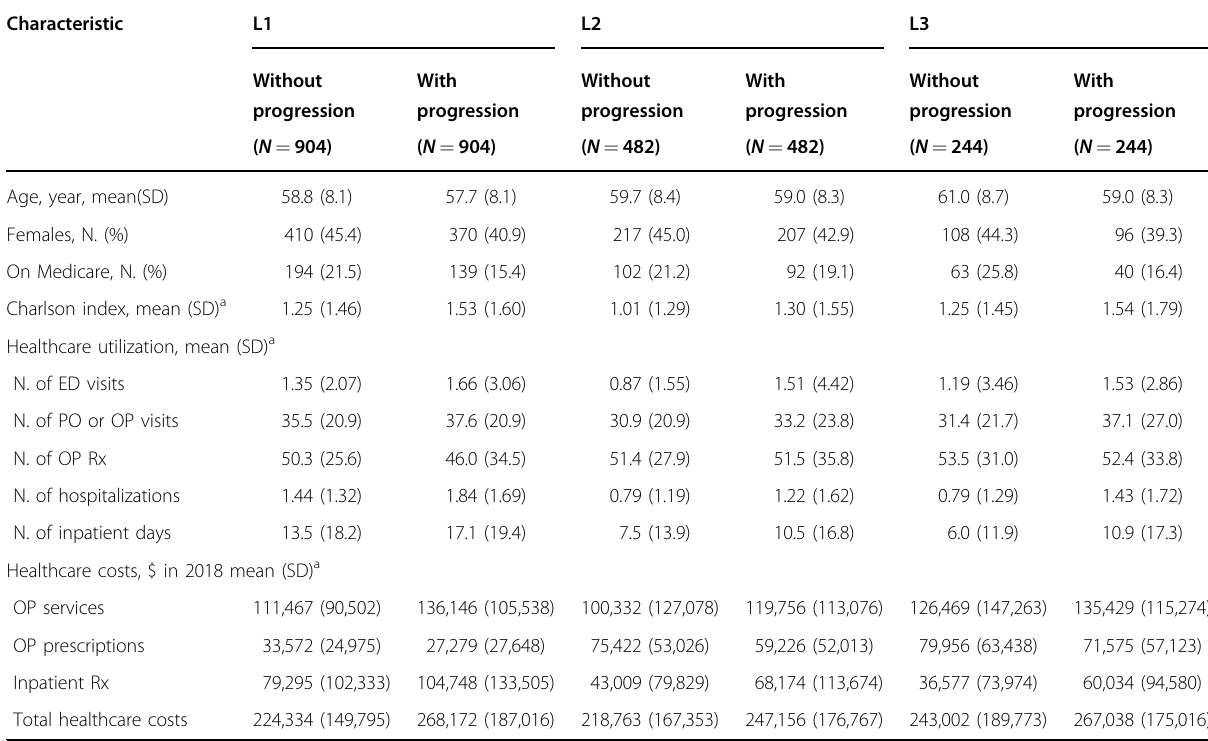
Table 1 Patient characteristics at index date by progression and LOT (for matched patients).